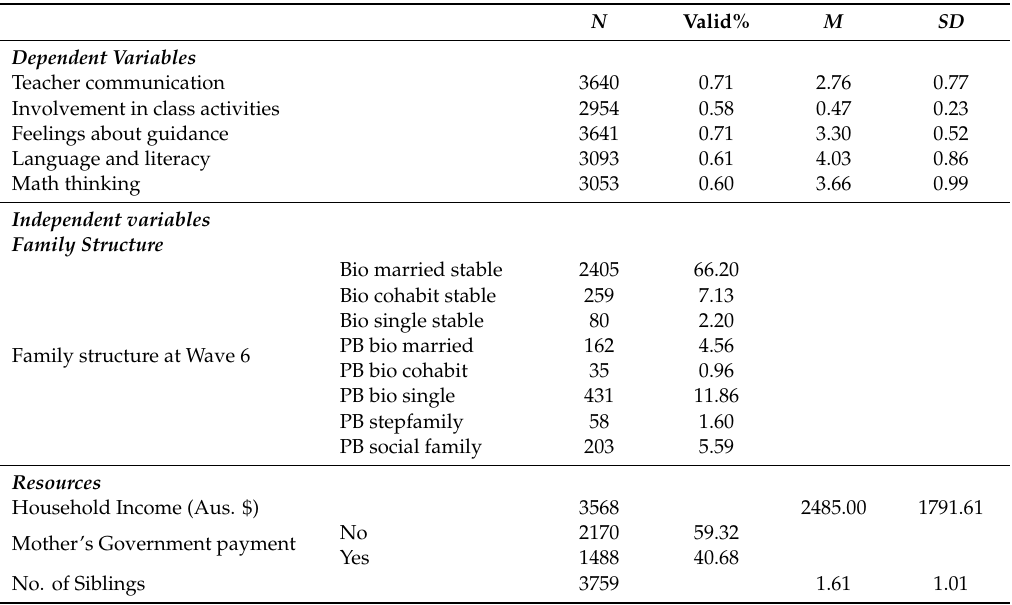
Table 2. Descriptive statistics of variables (wave